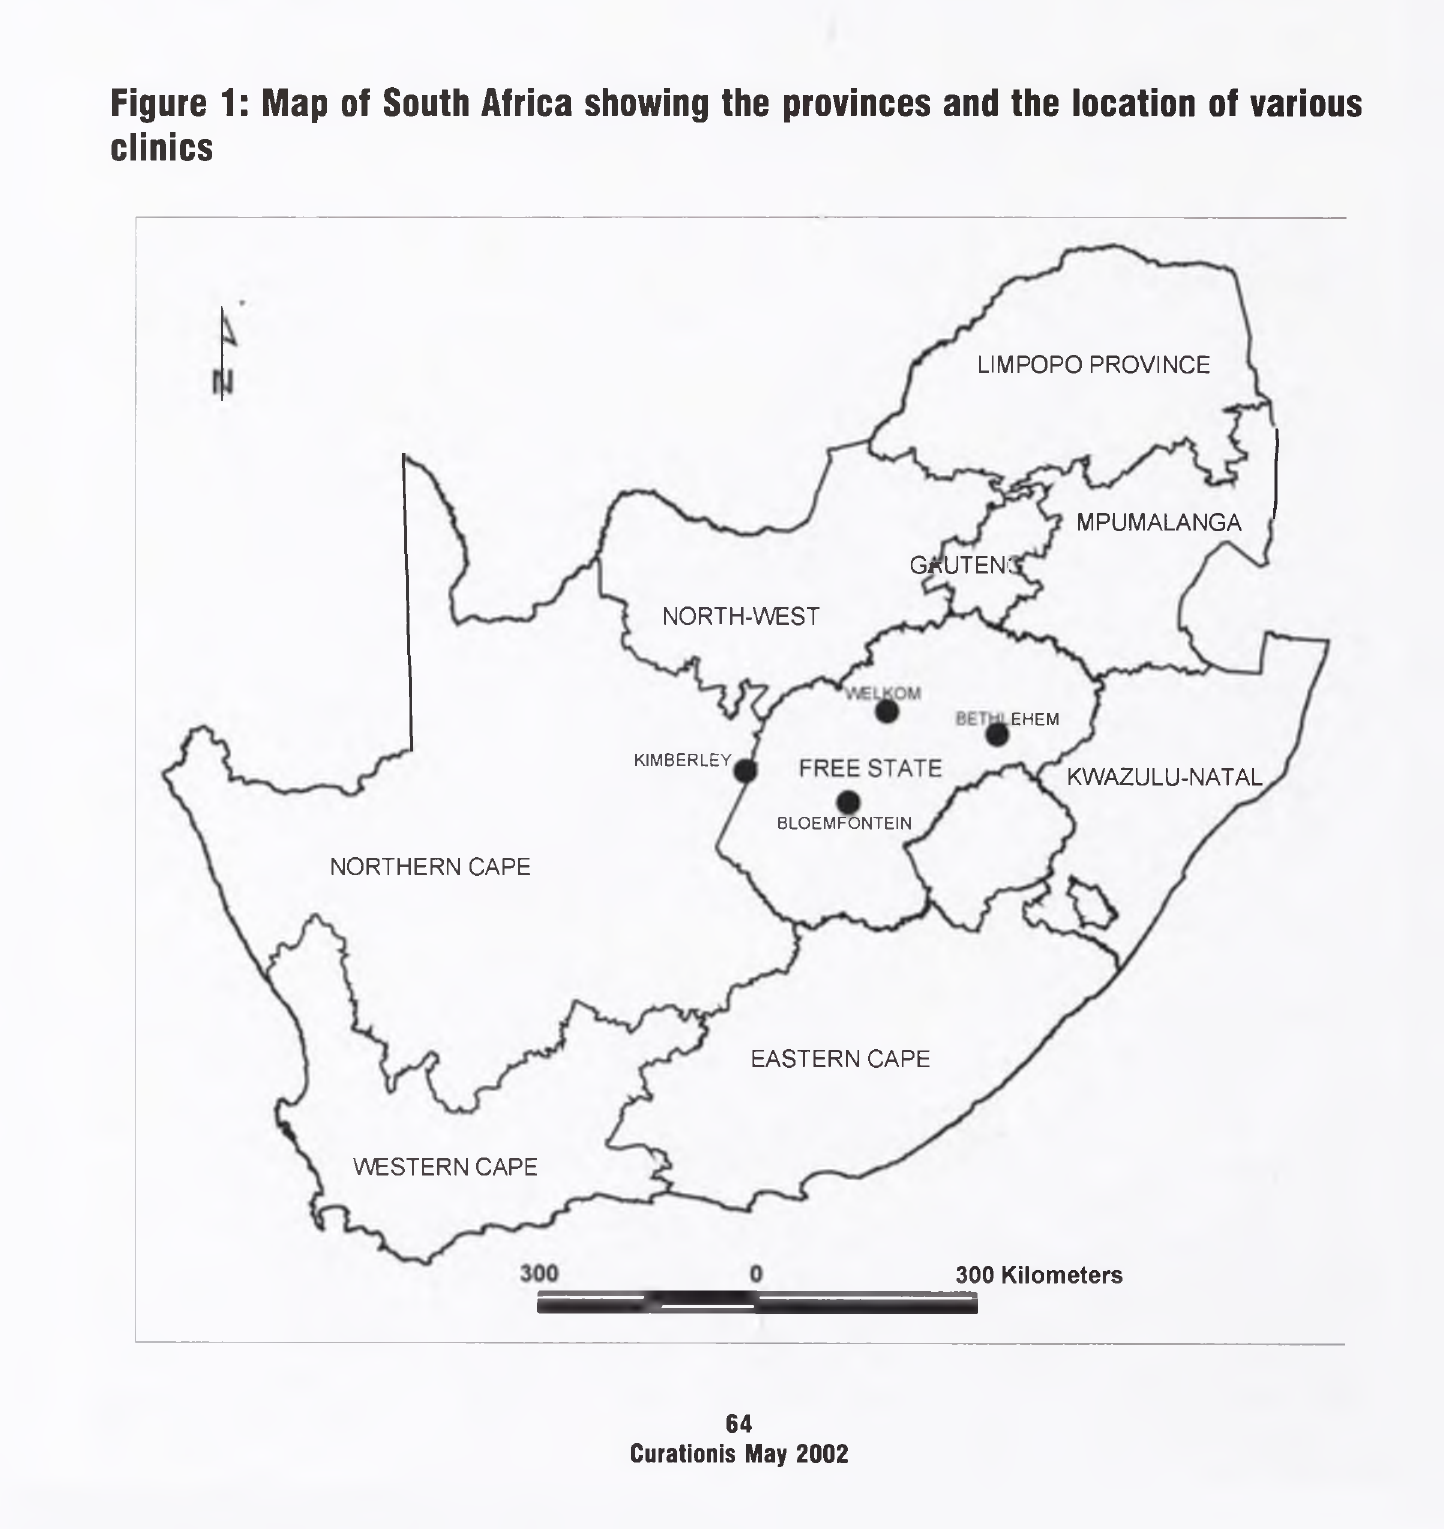
Figure 1: Map of South Africa showing the provinces and the location of various